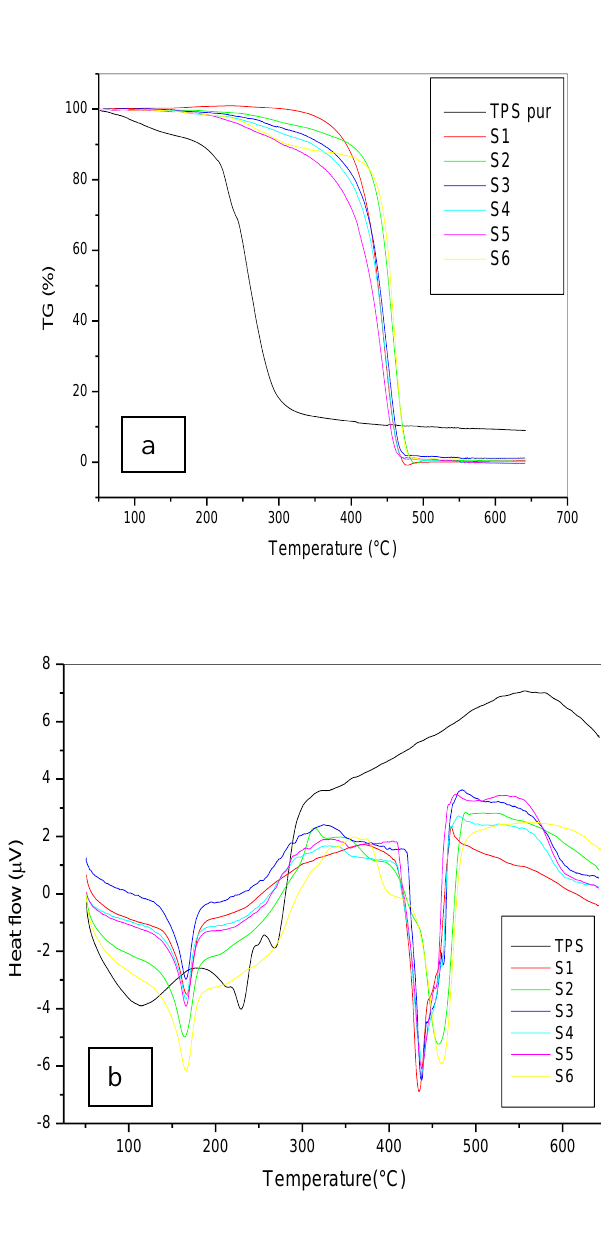
Fig. 9. TGA (a) and DTA (b) curves of TPS and PP/TPS /filler